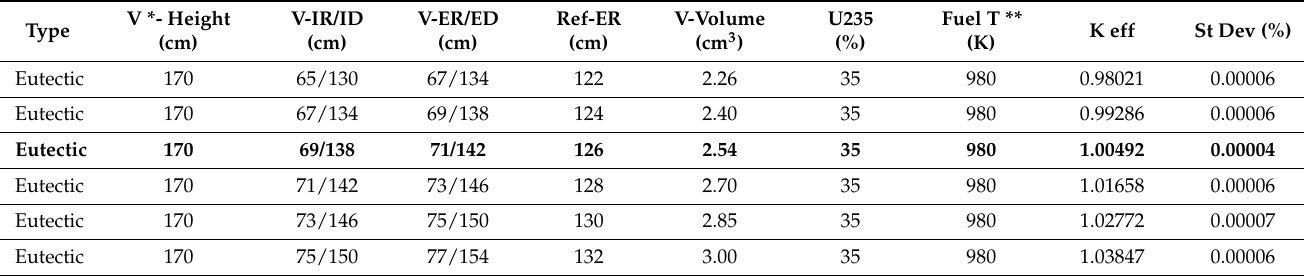
Table 6. Criticality search results for iMAGINE-Eutectic salt fuel system.